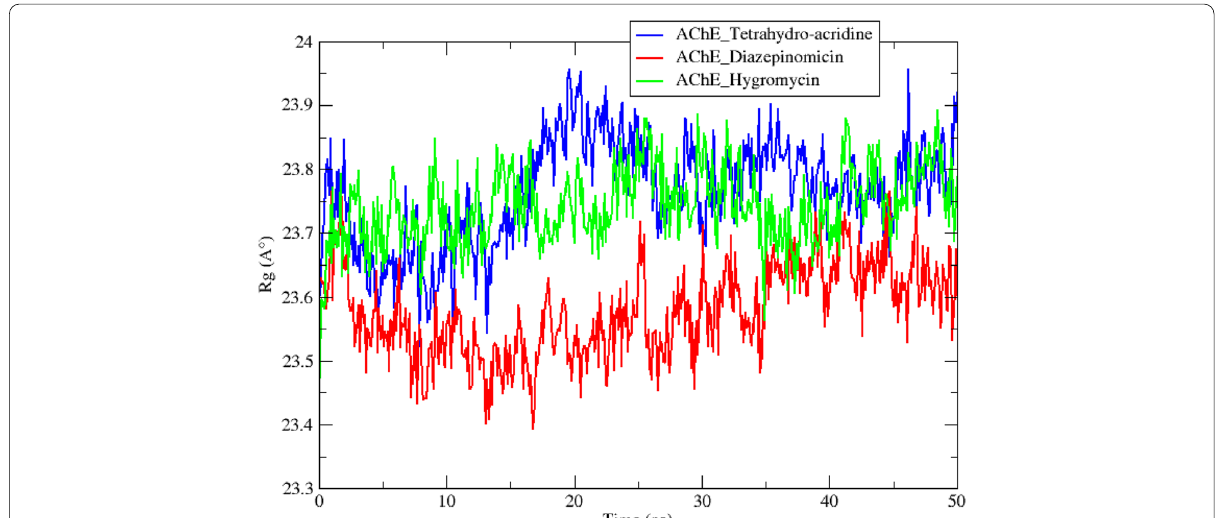
Fig. 6 Radius of gyration of the reference and the two top complexes during 50-ns MD simulations